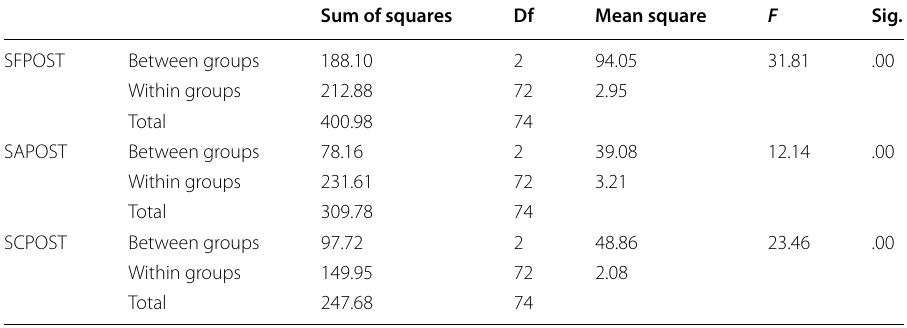
Sum of squares Df Mean square F Sig.